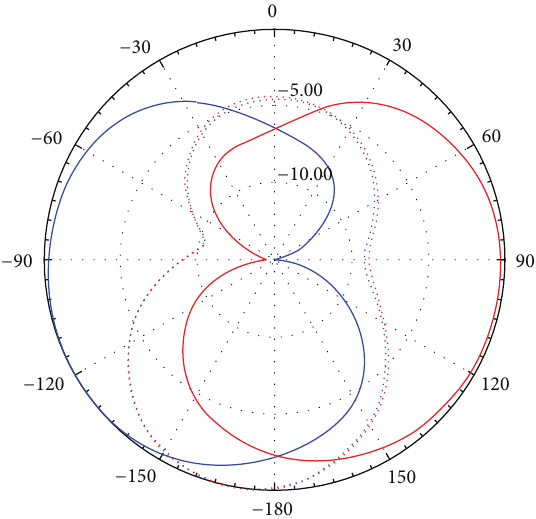
Figure 14: Simulated 𝑆 -parameters of the proposed pattern diversity tunable filter-antenna.